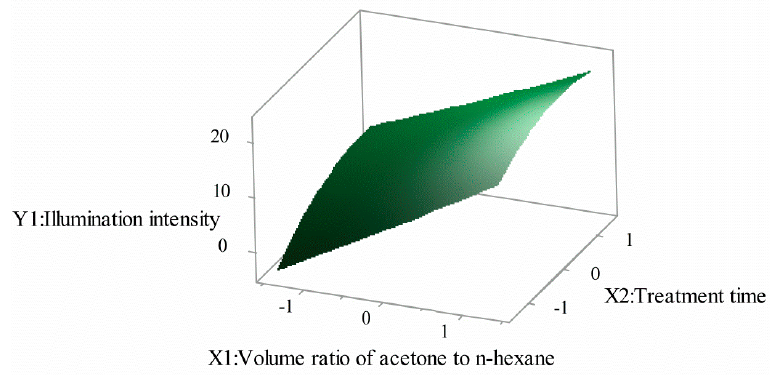
Figure 4. Volume ratio of acetone to n-hexane and treatment time for illumination intensity (3D).